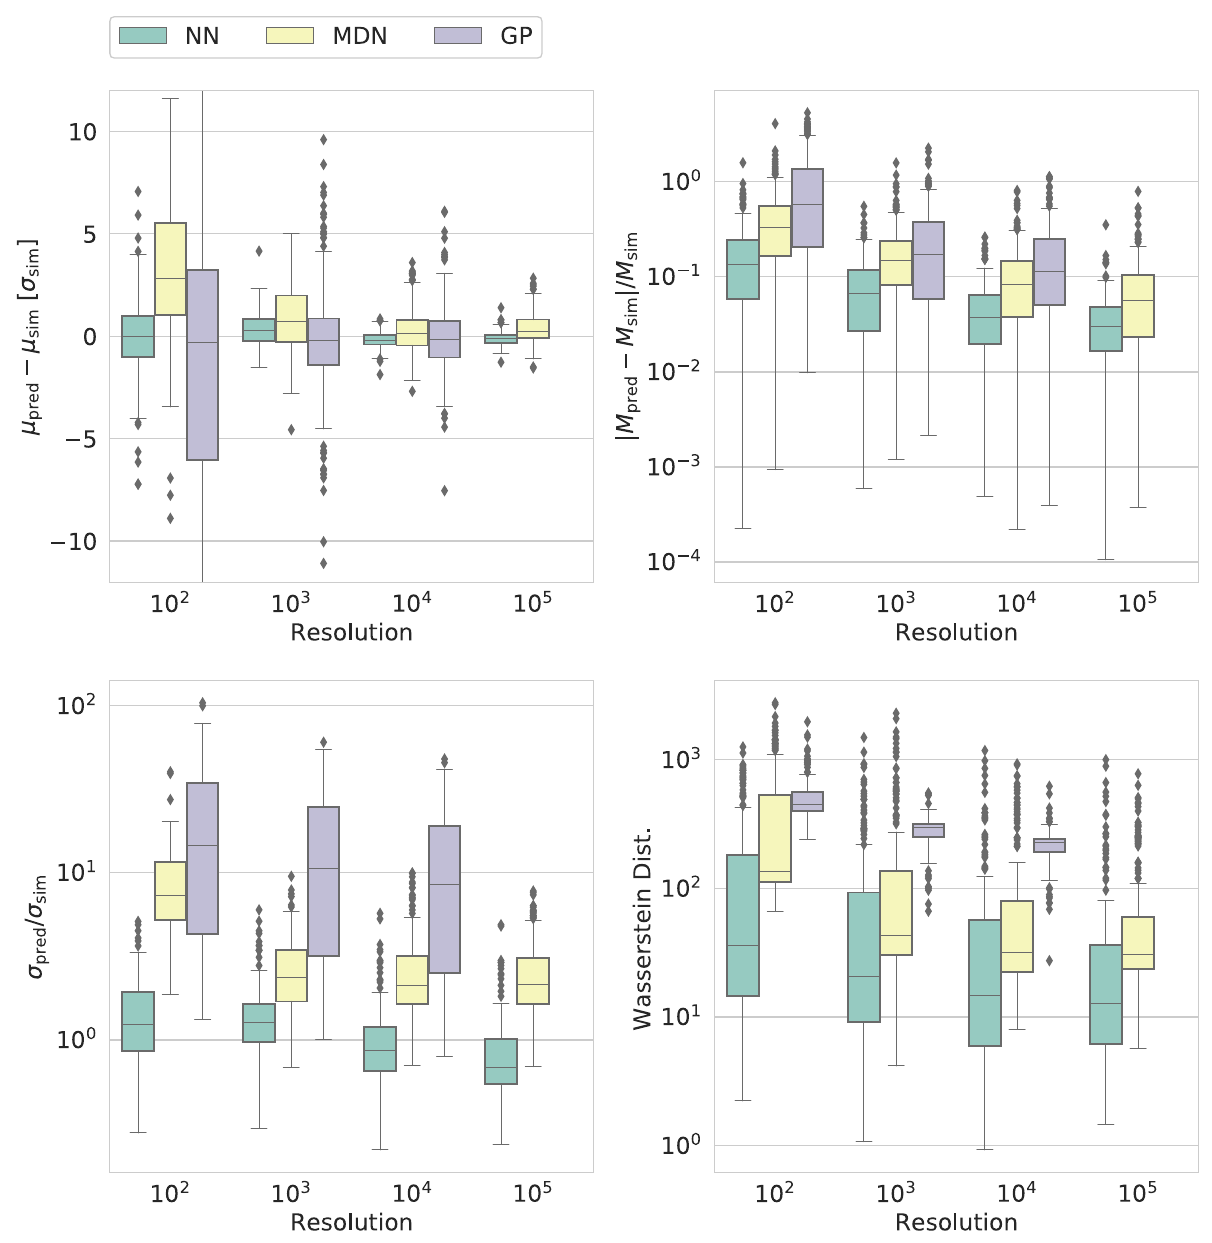
Fig 2. Comparison of the performance of the emulators as a function of the size of the training set (resolution) for the agent-based cellular automata (CA) model of brain tumours. The plot shows the results for three emulators: A neural network (NN), a mixture density network (MDN), and a Gaussian process (GP). The subscripts ‘pred’ and ‘sim’ refer to the predictions by the emulators and the ground truth obtained from simulations, i.e. the synthetic data, respectively. The four panels contain our four performance metrics for emulators: the error in the predicted mean ( μ pred ), the relative absolute error in the predicted median ( M pred ), the ratio between the predicted width of the marginals in terms of the standard deviation ( σ pred ) and true width, and the Wasserstein distance (cf. the section Metrics ). The figure summarizes these quantities for one of the output variables of the CA model, the number of glioblastoma stem-like cells (GSC). For the other outputs, we refer the reader to S7